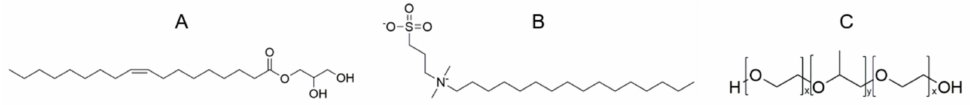
Figure 1. The structure of chemicals: ( A ) glycerol monooleate; ( B ) 3-(Hexadecyldimethylammonio) propane-1-sulfonate; ( C ) poloxamer formula: x and y are the lengths of polyepoxyethane (PEO) and polyepoxypropane (PPO) chains; the weight ratio of oxirane to 1,2-epoxypropane in poloxamer 407 is